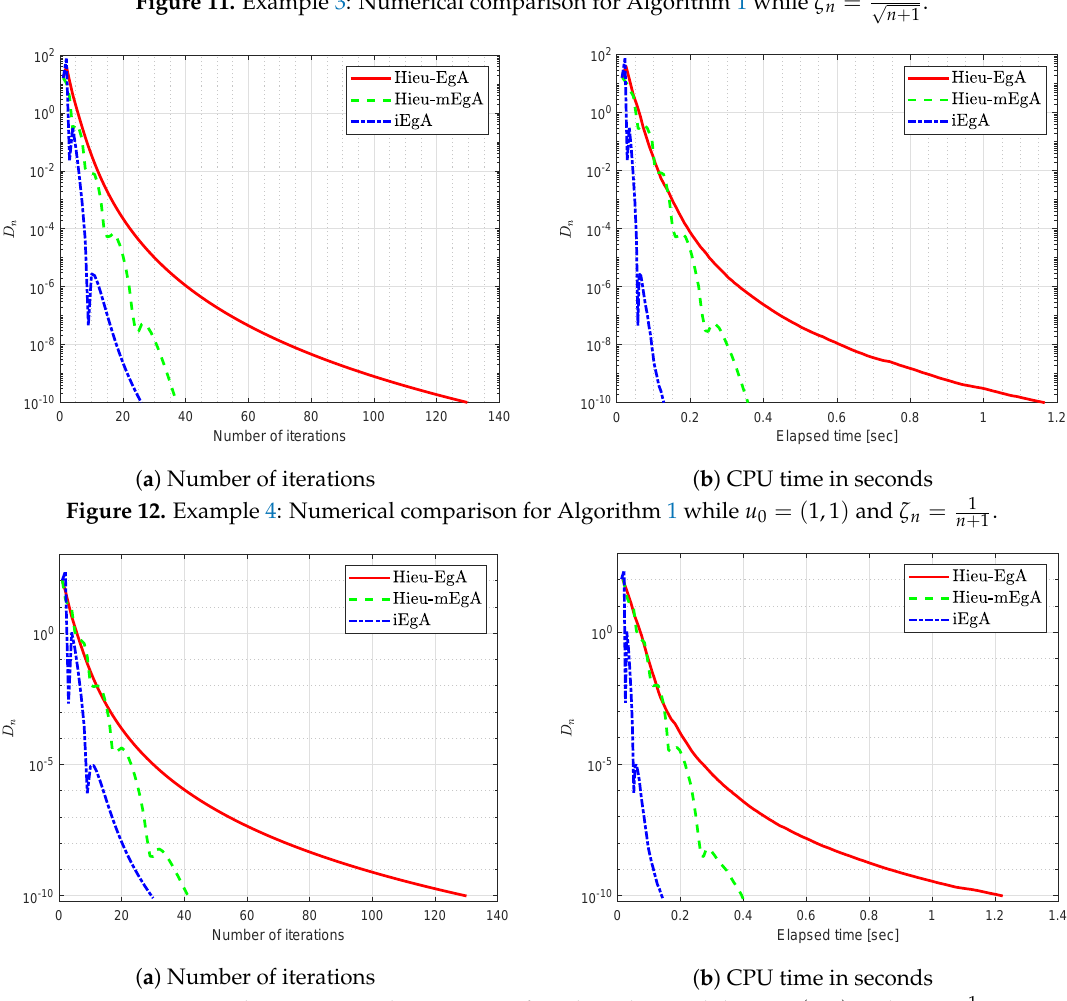
Figure 13. Example 4: Numerical comparison for Algorithm 1 while u 0 = ( 4,4 ) and ζ n = 1